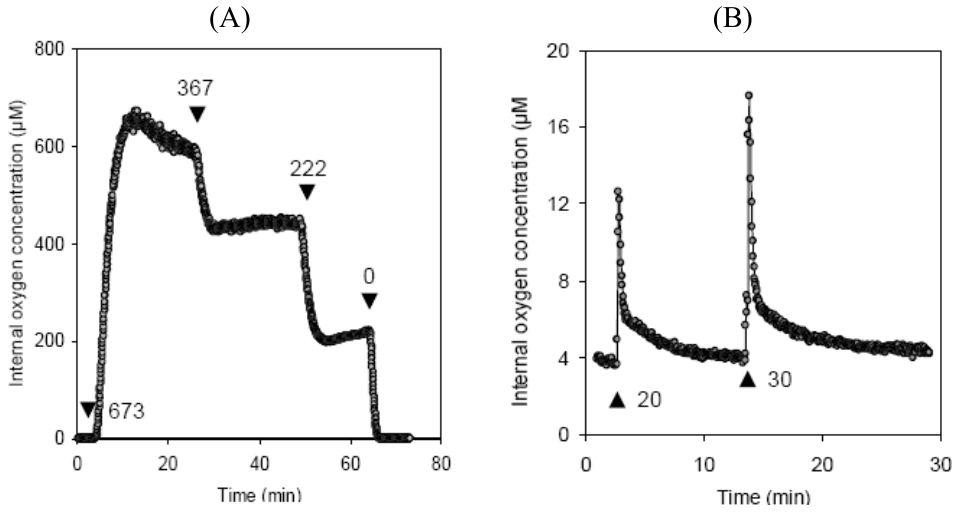
Figure 2. Dynamics of steady state oxygen concentration in seeds. (A) Oxygen